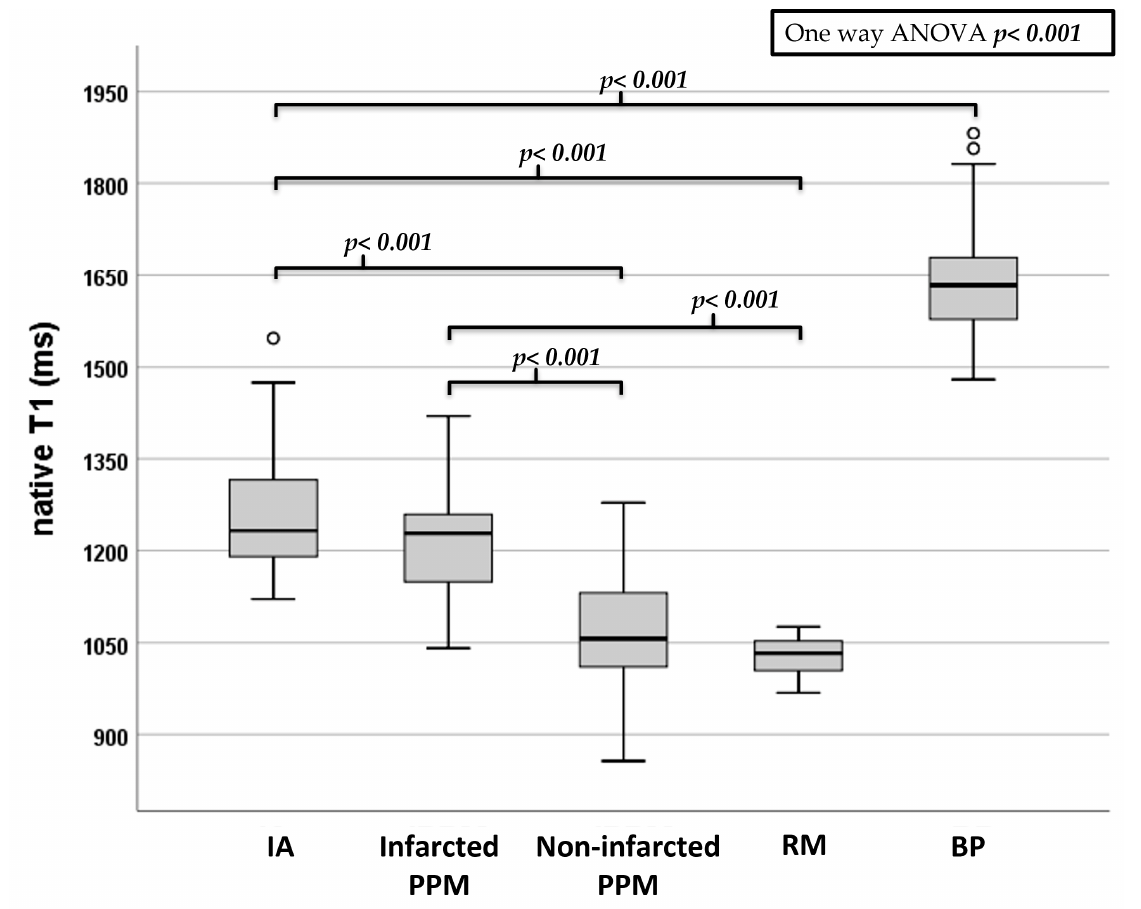
Figure 3. Box plot graph showing the nT1 values of the different ROIs placed in the myocardium and PPMs. Error bars represent the 95% confidence interval (CI), and the top and the bottom of the boxes represent the third and the first quartiles, respectively. p -values were calculated with one-way ANOVA and Bonferroni post-hoc analysis and considered significant when <0.05. ANOVA: analysis of variance; ms: milliseconds; IA: infarcted area; RM: remote myocardium; BP: blood pool.